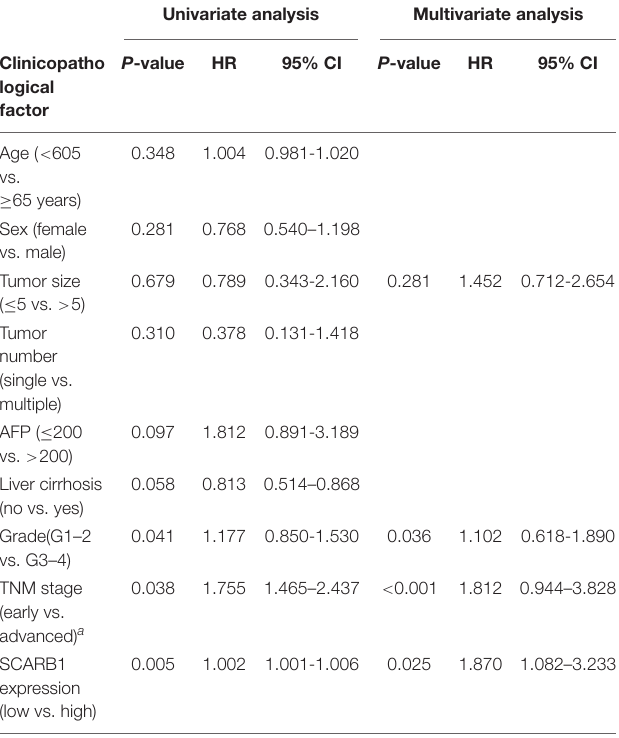
TABLE 3 | Multivariate analyses of factors associated with DFS. Univariate analysis Multivariate